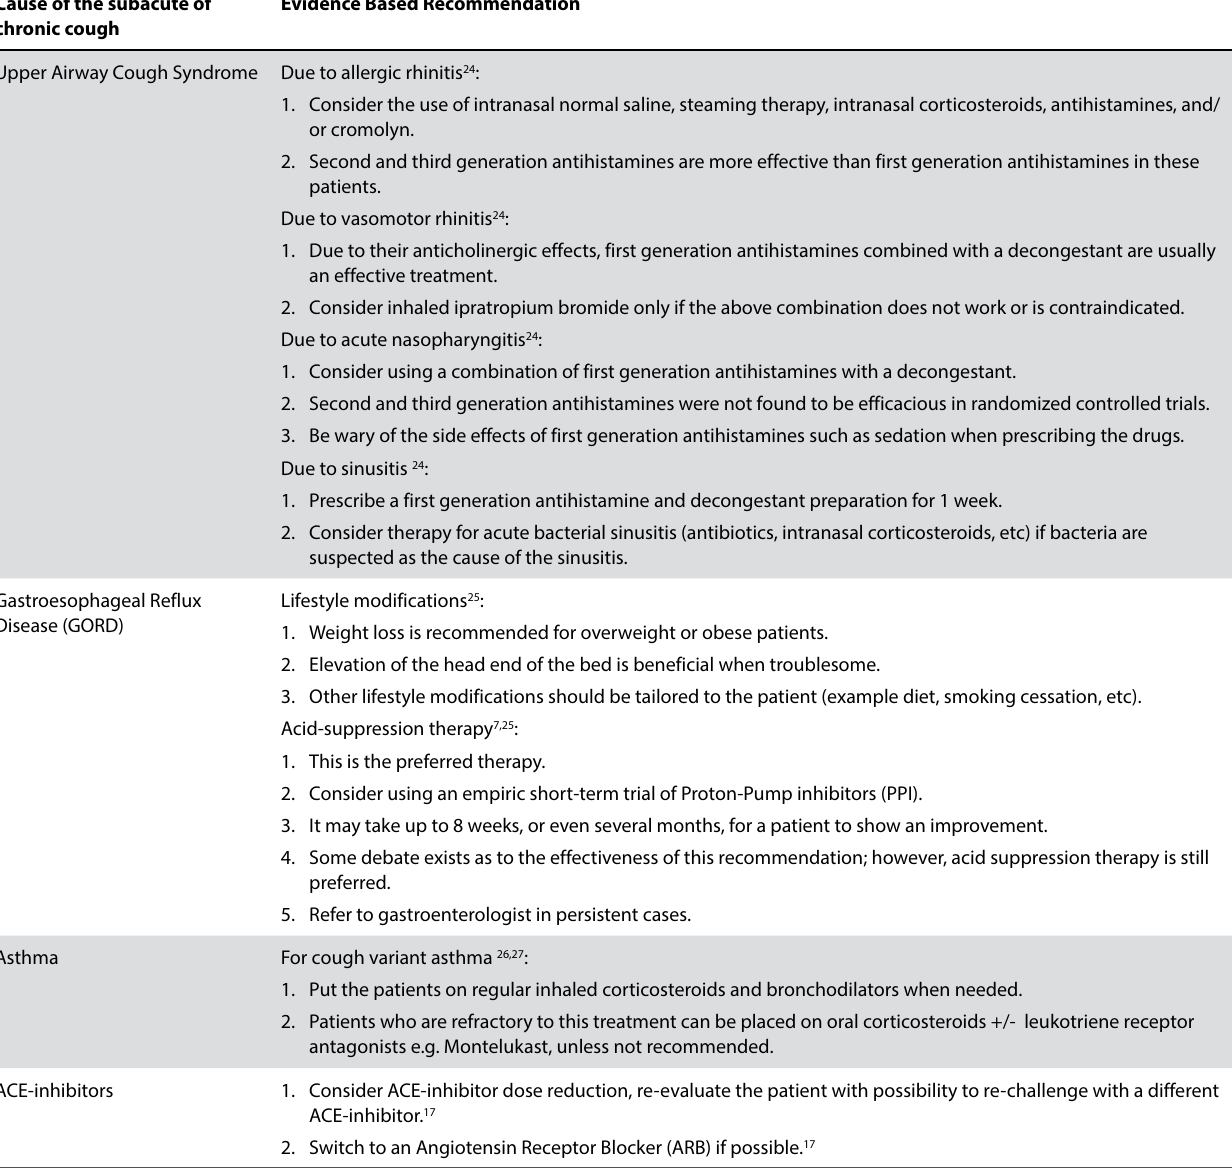
Table 2: Treatment recommendations for the specific causes of subacute and chronic cough Cause of the subacute of Evidence Based Recommendation chronic cough Upper Airway Cough Syndrome Due to allergic rhinitis 24